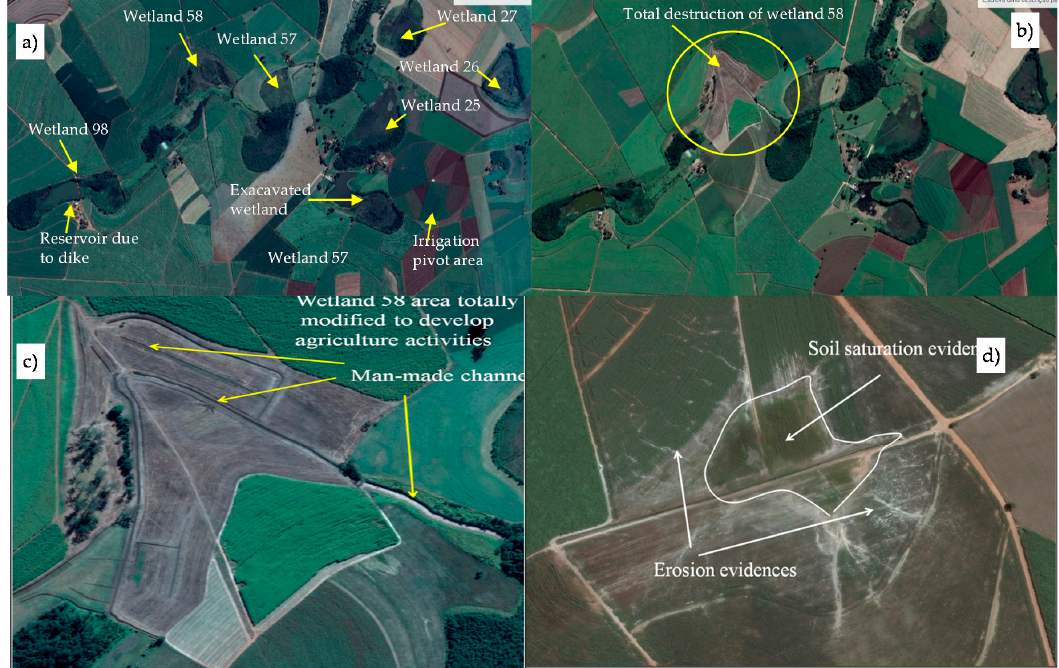
Figure 12. Examples of environmental changes: ( a ) set of wetlands highlighting Wetland 58—October 2013; ( b ) Wetland 58—June 2017; ( c ) detail of Wetland 58, ( d ) wetland that was totally modified by agricultural activities, had been ditched, and presented evidence of erosion.